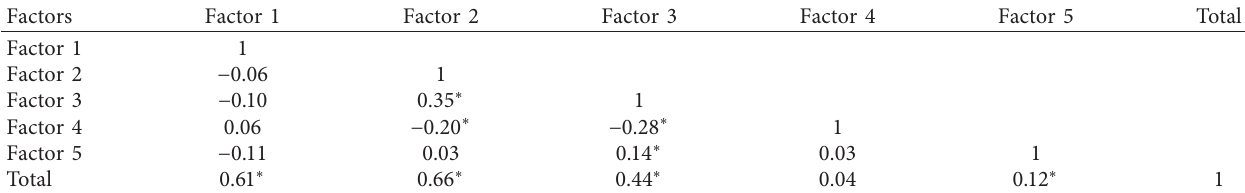
Table 6: Correlations between the factors affecting the hypertensive treatment adherence scale score and its subscales.